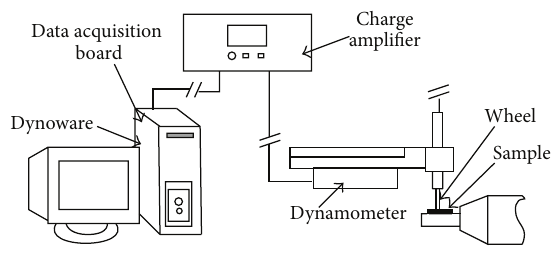
Figure 8: Schematic of force measurement instrument. Table 2: Material properties of silica glass